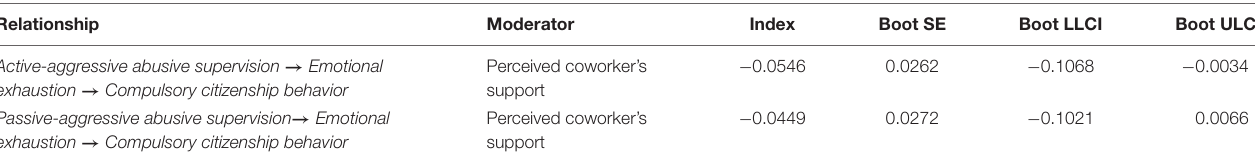
TABLE 9 | Index of moderated mediation. Relationship